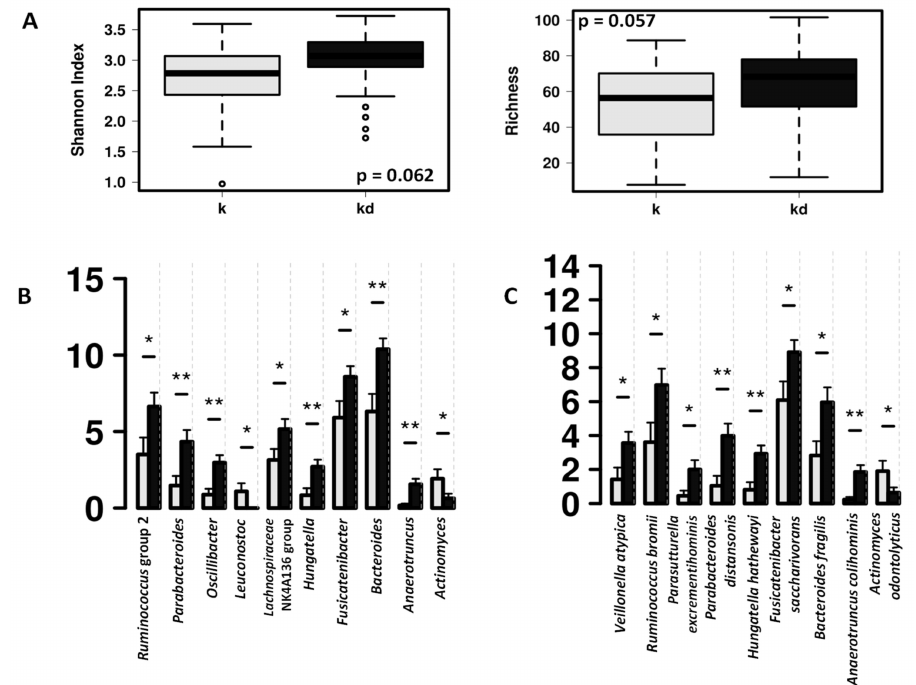
Figure 2. Differences in fecal microbiota between children from allergy risk families with dogs (k, grey) and without dog (kd, black). ( A ) Box and whisker plots showing differences in fecal microbial diversity (Shannon index) and richness at the ASV level. ( B ) Significant differences in the relative abundance at genus level. ( C ) Significant differences in the relative abundance at species level. * indicate significant differences at p < 0.05, ** indicate significant differences at p < 0.01 after ANOVA